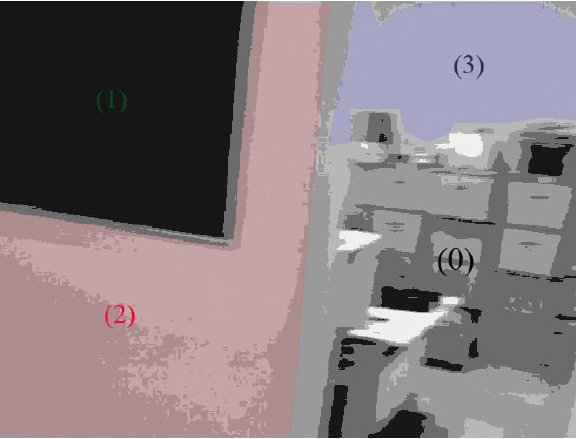
Figure 9. Smoothing filter which is used for accuracy field computation.